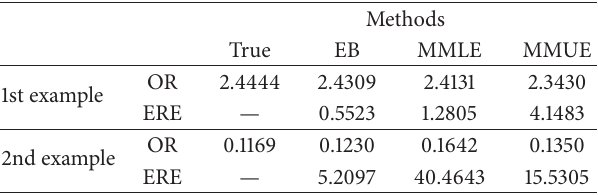
Table 7: True odds ratios and their estimates using EB, MMLE, and MMUE, with corresponding percentages of